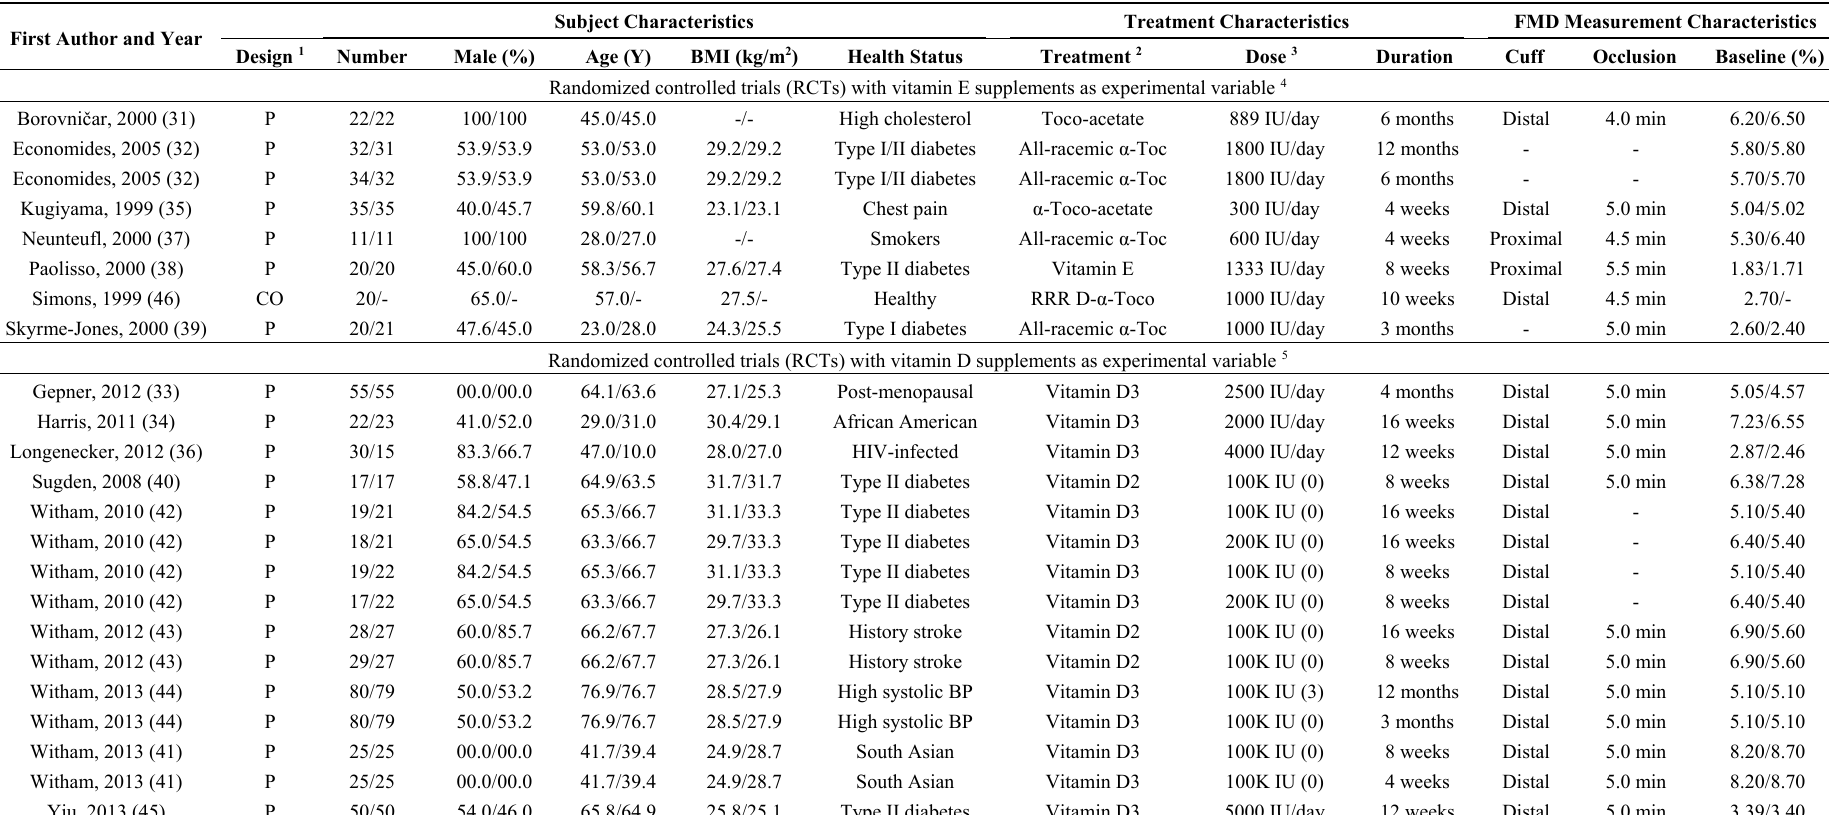
Table 1. Overview of randomized placebo-controlled trials included in the